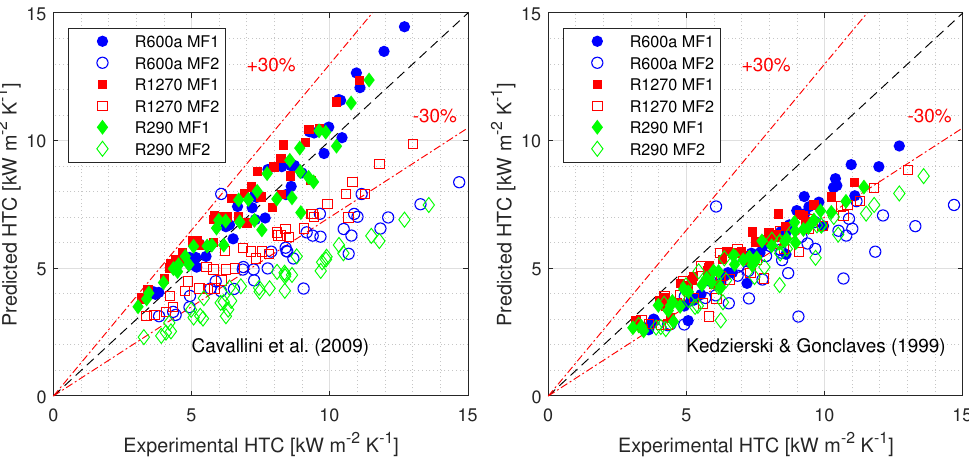
Figure 14. Prediction of HTC in two microfinned tubes by correlations of Cavallini et al. [39] and Kedzierski and Goncalves [41] compared to experimental